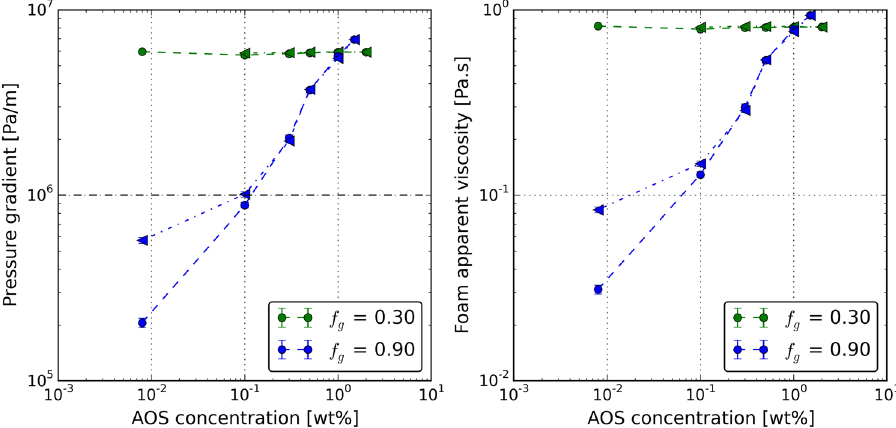
Figure 8. ( a ) The pressure gradient along the core and ( b ) the calculated apparent viscosity at different surfactant concentrations. The horizontal black dashed line in 8a indicates the critical pressure gradient below which the hysteresis in foam generation